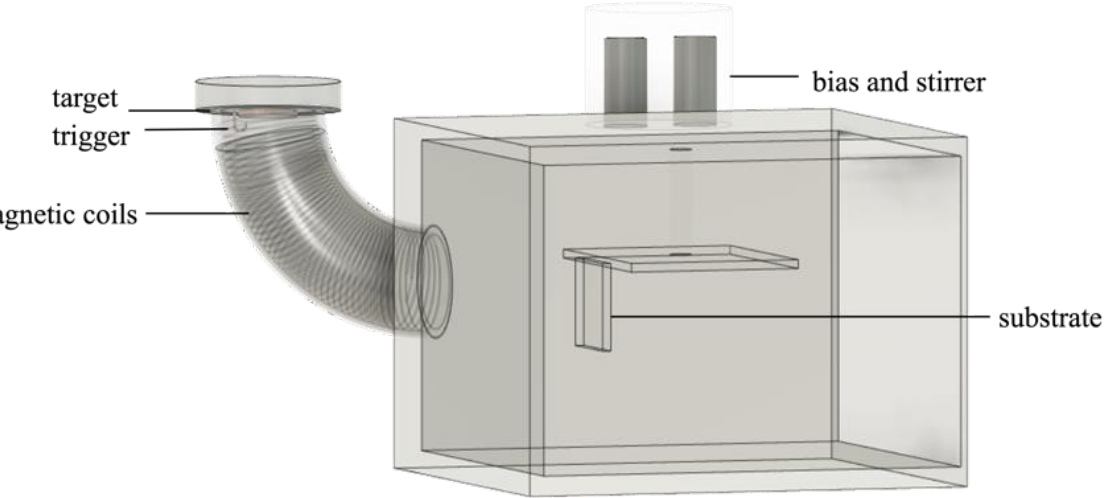
Figure 1. Schematic diagram of the magnetic-filtered vacuum arc deposition system.